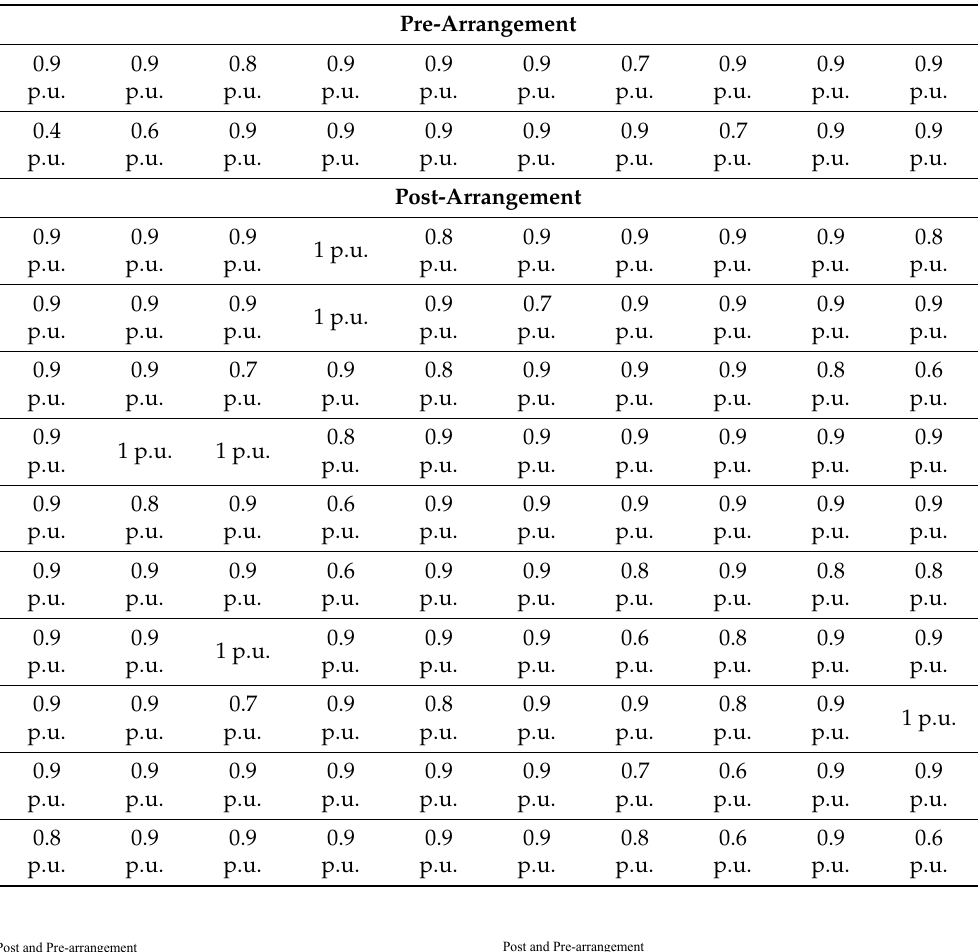
Table 10. Cont . Table 10. The parameters associated with the two types of 10 × 10 PV arrays (i.e., 18-kW and 43- kW) after application of reconfiguration in 14 different countries.